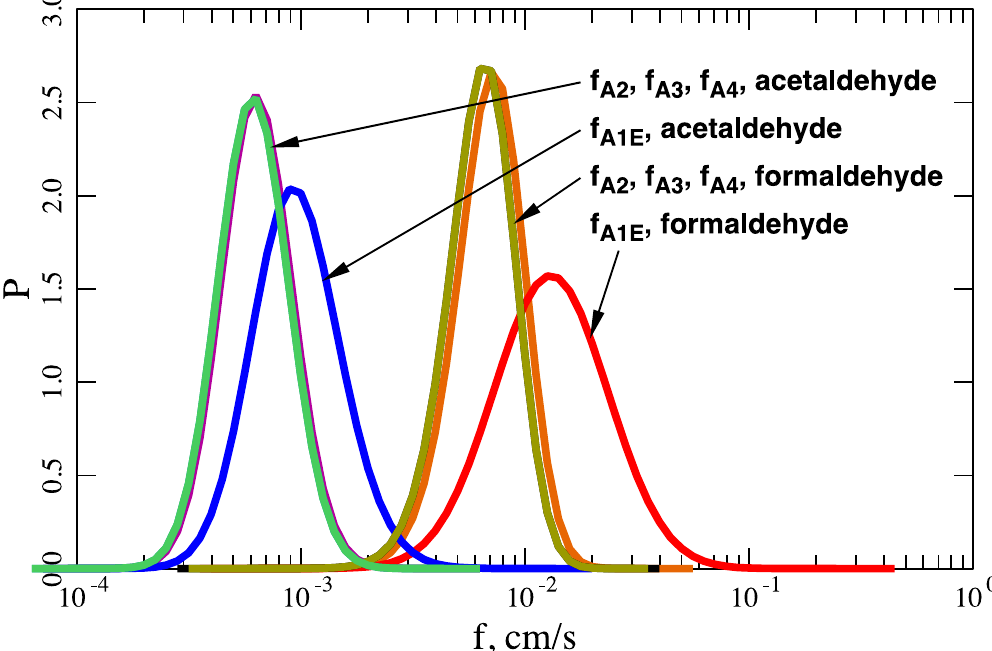
Figure 7. Distributions of f A1E , f A2 , f A3 , and f A4 when model parameters are selected according to Table 7. The curves for f A2 , f A3 , and f A4 are practically identical at the resolution of the figure. Results for k 21A between 10 − 6 s − 1 and 10 − 2.5 s − 1 have all been included, but also cannot be resolved.